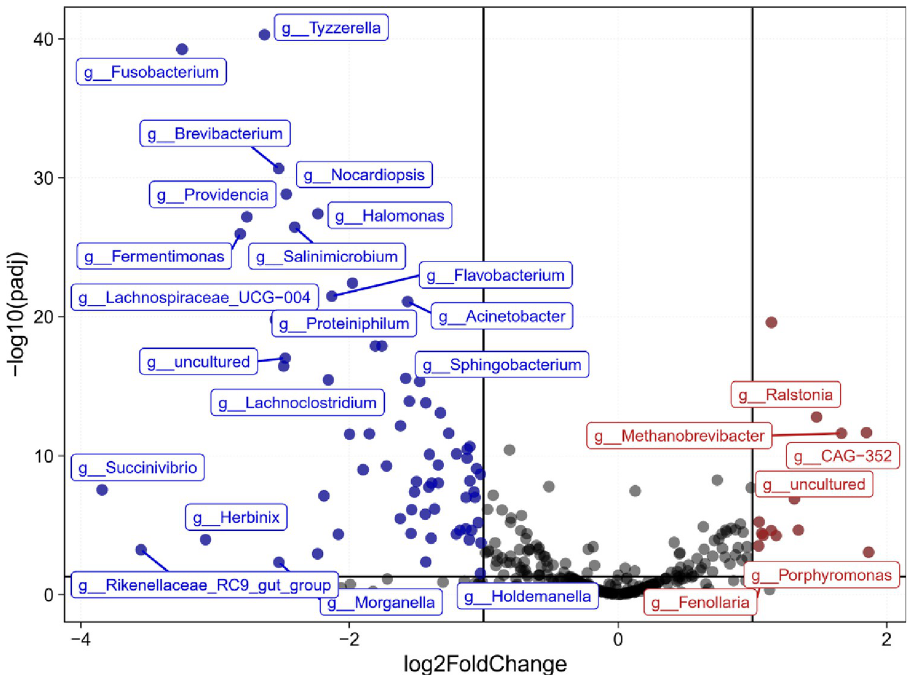
Fig 6. Volcano map of the genus-level microbial communities with different abundance in the CKD group compared with HC group. Most of the bacteria with decreased abundance belonged to Firmicutes, Bacteroidota, Proteobacteria, and